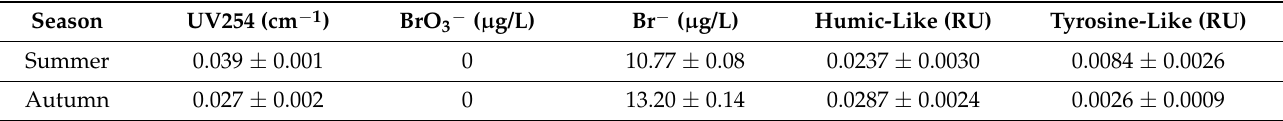
Table 1. The quality results of raw water after DMRF (average values with standard deviation).